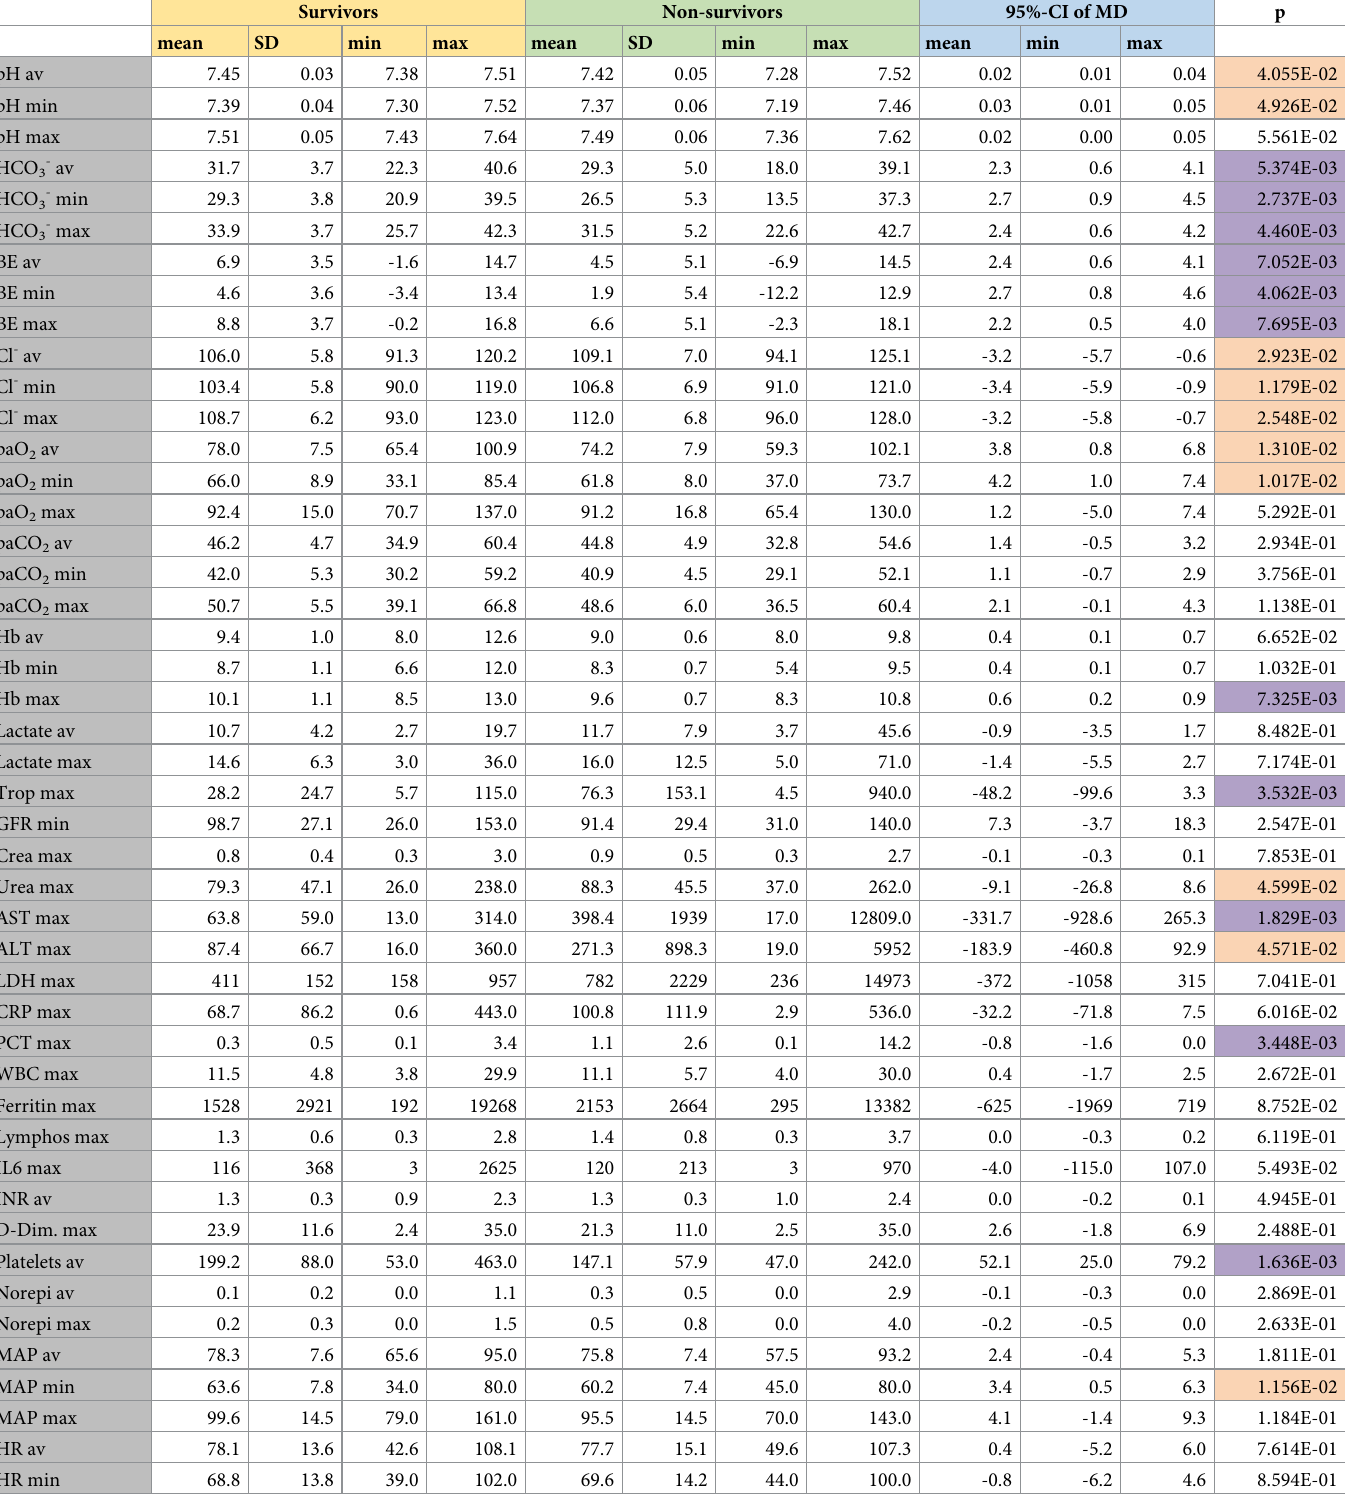
Table 3. Parameters for ICU treatment on day 10 after the start of veno-venous extracorporeal membrane oxygenation (VV ECMO). Survivors Non-survivors 95%-CI of MD